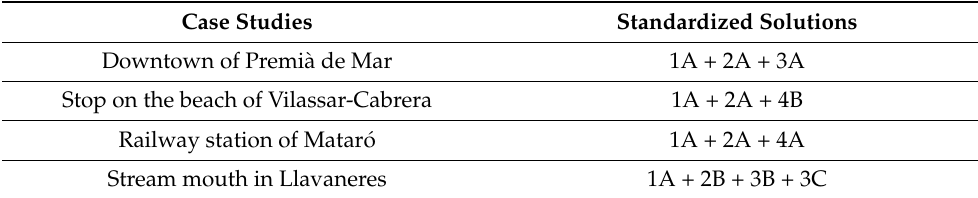
Table 5. Standardized solutions applied to case